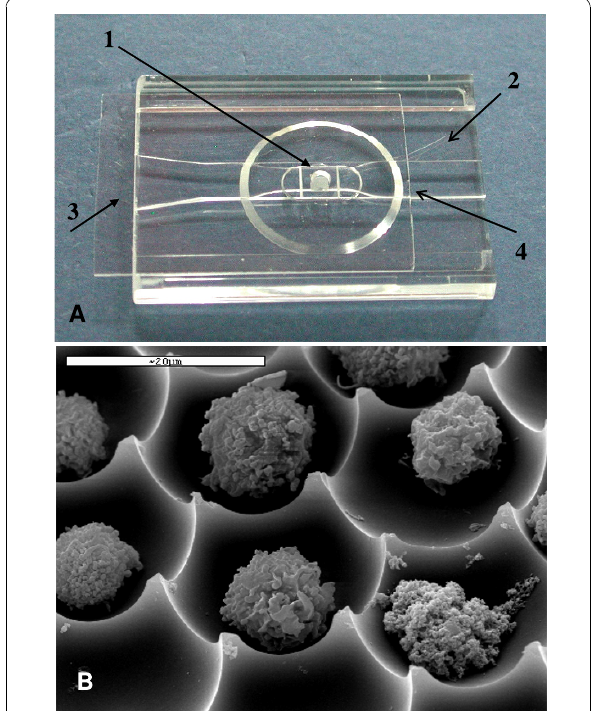
Figure 1 The individual-cell-based cryo-chip (i3C) . (A) The 2.5 ml cell chamber (1), whose glass bottom contains the picowells (small opaque region inside the chamber), which are engraved into the i3C plastic body (2). The cover slip (3) is moved left to enable access to the cell chamber opening, through which the cell suspension is loaded. The cover slip is then returned to its position in order to secure the content of the cell chamber when the liquids are poured into the entrance of the open conduit (4), formed by the space between the cover slip and the plastic ‘ step bridge ’ . Flow to the left is then established via capillary forces developed between the cover slip, the bridge and the poured liquid. (B) SEM micrograph of U937 cells in their picowells, as they appear at the bottom of the cell